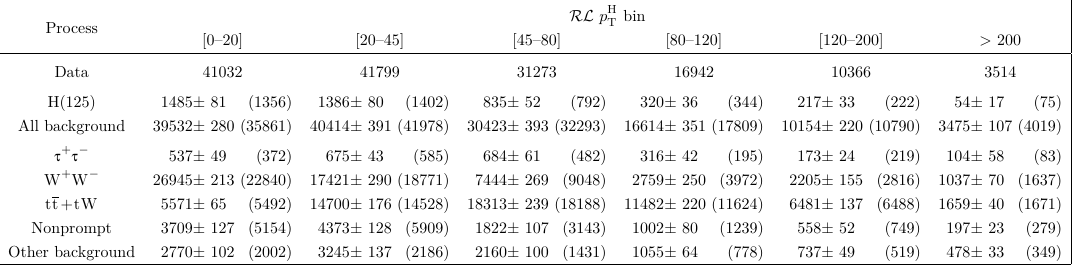
Table 5 . Signal and background post-fit (pre-fit) yields in the RL p H